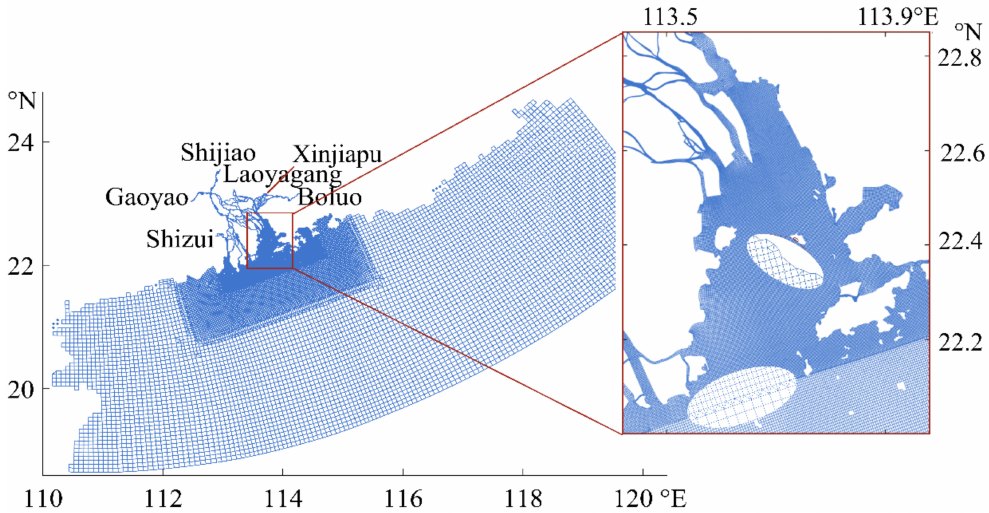
Figure 2. Numerical model grids of the basic scenario. The insert is the refined grid of the area of